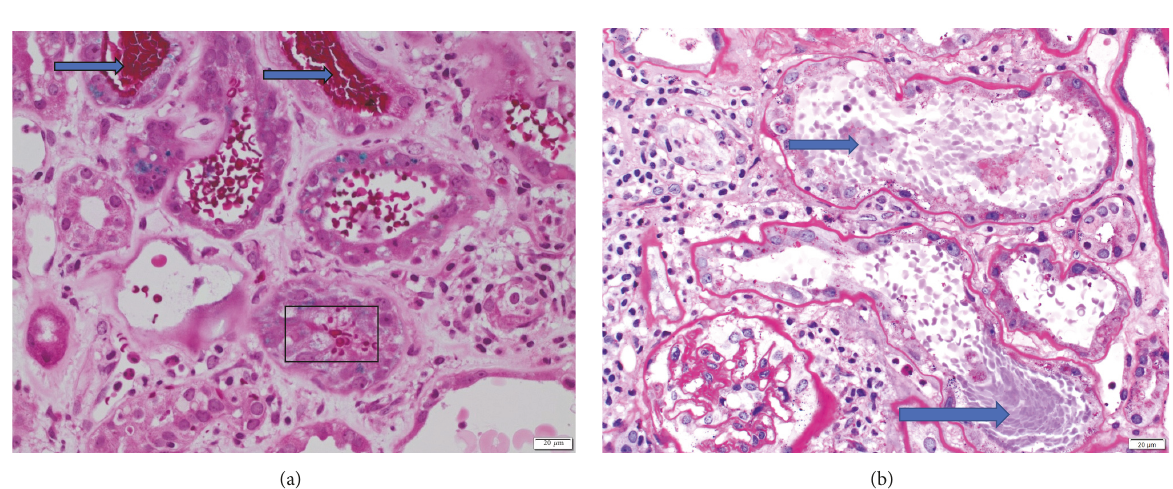
Figure 2: Kidney biopsy histopathology I. (a) Kidney biopsy shows presence of abundant RBCs (box) and RBC casts (arrows) (Periodic Acid Schiff stain, Light Microscopy, Magnification: X200). (b) Kidney biopsy shows acute tubular injury with loss of brush borders, attenuated tubular epithelium, and reactive epithelial changes. RBC casts (arrows) indicate significant hemorrhage in tubules. The mesangium of glomerulus is minimally expanded with no evidence of proliferation. (Periodic Acid Schiff Stain, Light Microscopy, Magnification: